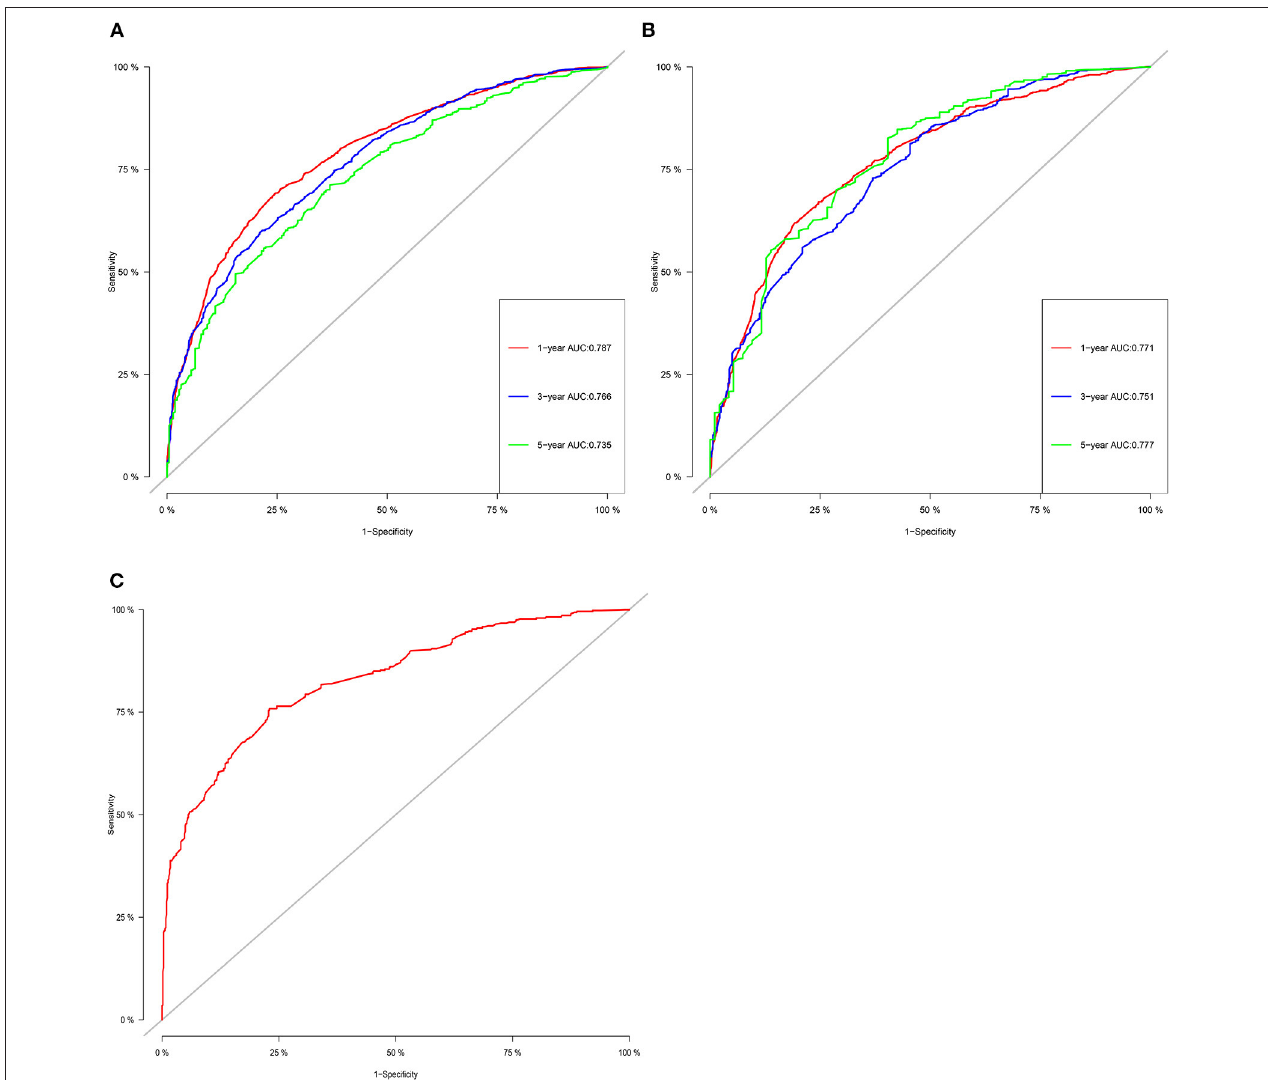
FIGURE 4 | The ROC for OS of 1-, 3- and 5-year of training cohort (A) , validation cohort (B) , and external validation cohort (C)